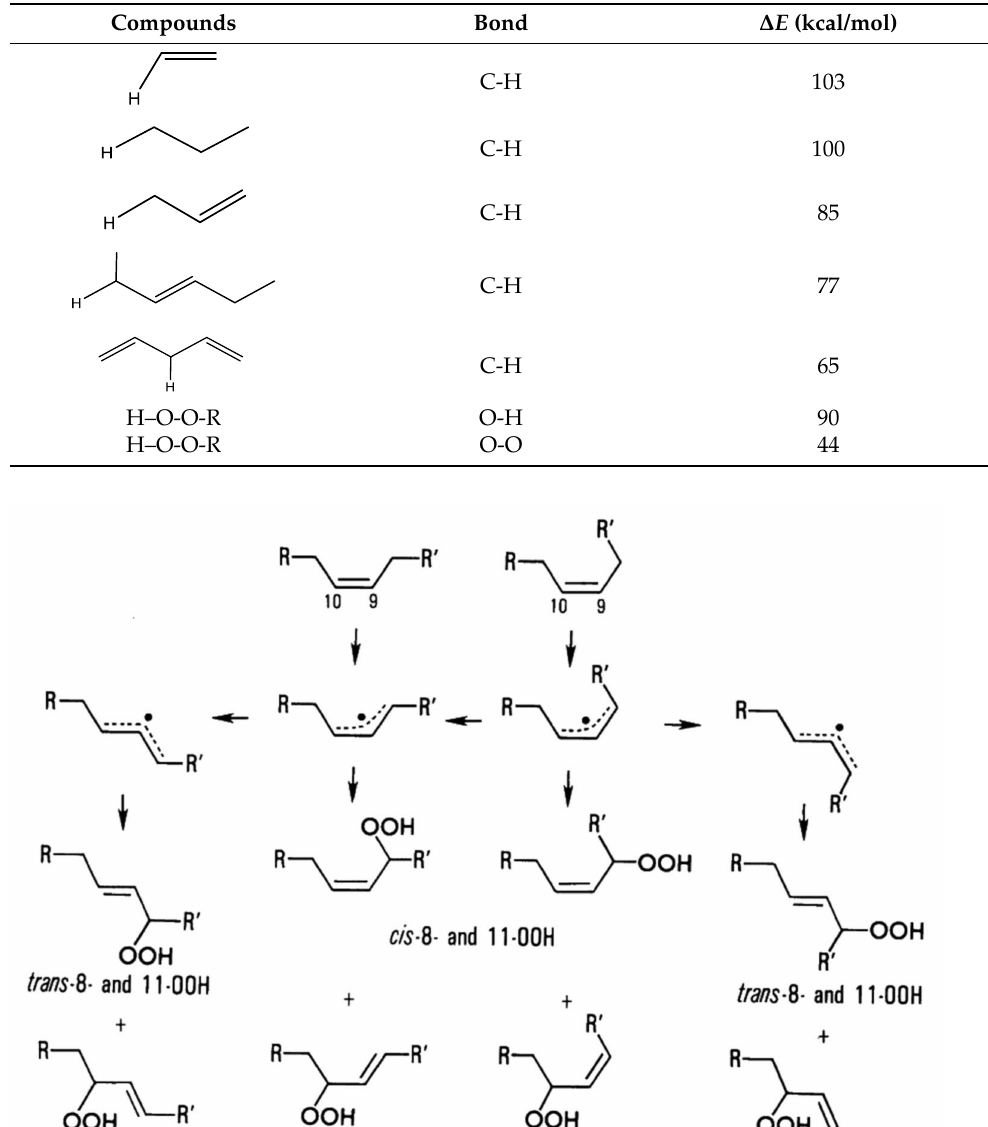
Table 1. Dissociation energies of C-H, O-H and O-O bonds in various compounds [8]. Compounds